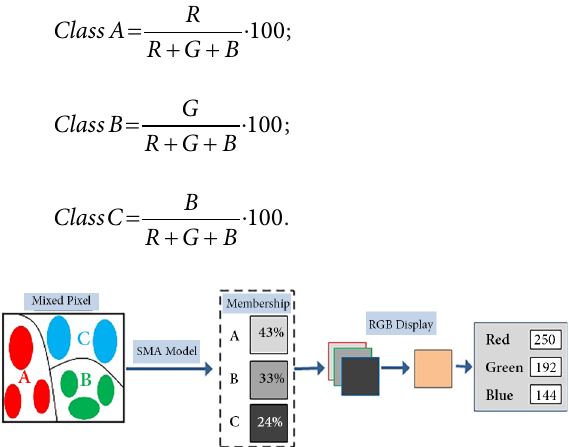
Figure 2. Graphical chart of transformation fractional images to RGB color